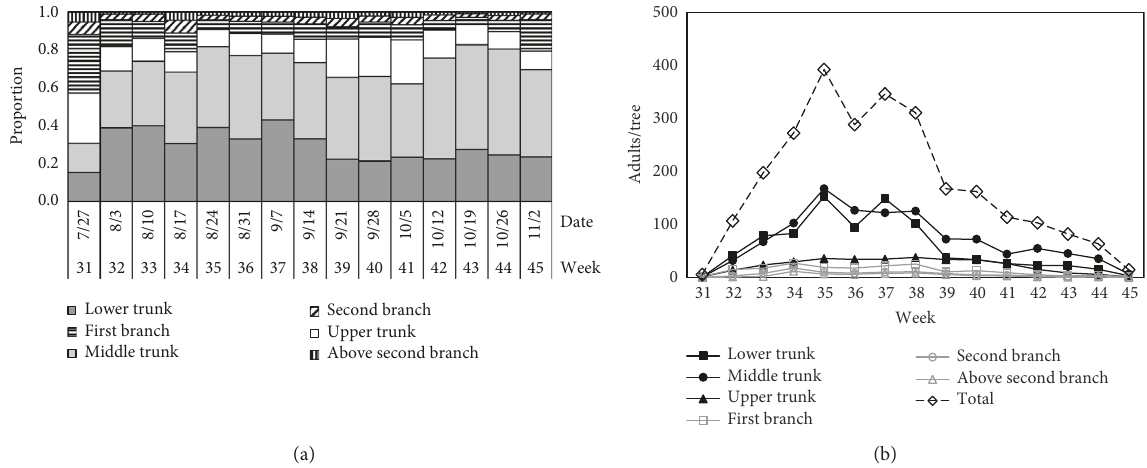
Figure 4: Seasonal composition of Lycorma delicatula adult at different within-tree positions (a) by proportion and (b) by mean ( ± SD)